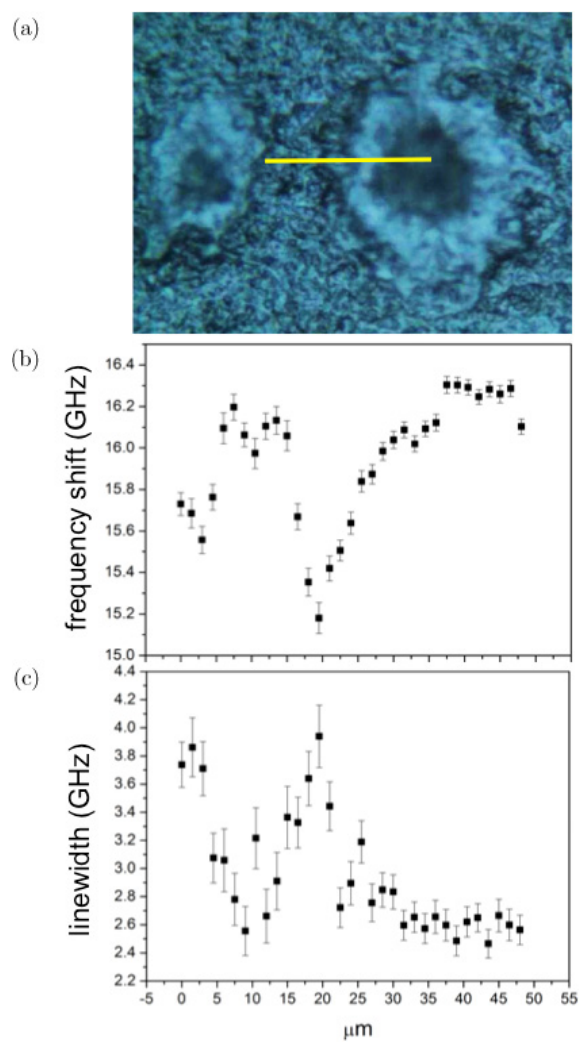
Fig. 4. (Coloronline)Photomicrographandresultsof¯tanalysis applied to Brillouin spectra of a TASTPM mouse brain hippo- campal section. (a) Photomicrograph obtained using a Renishaw inVia Raman microscope with 20 (cid:1) objective. (Yellow line denotes a50 (cid:2) mlongregion,whereBrillouinspectrawereacquiredthrough line scanning using a 1.5 (cid:2) m step-size.) Plots of the (b) frequency shift and (c) linewidth of the Brillouin peak derived from ¯t analysis of the spectra in the linear scan; error bars indicate the standard error (square root of number of